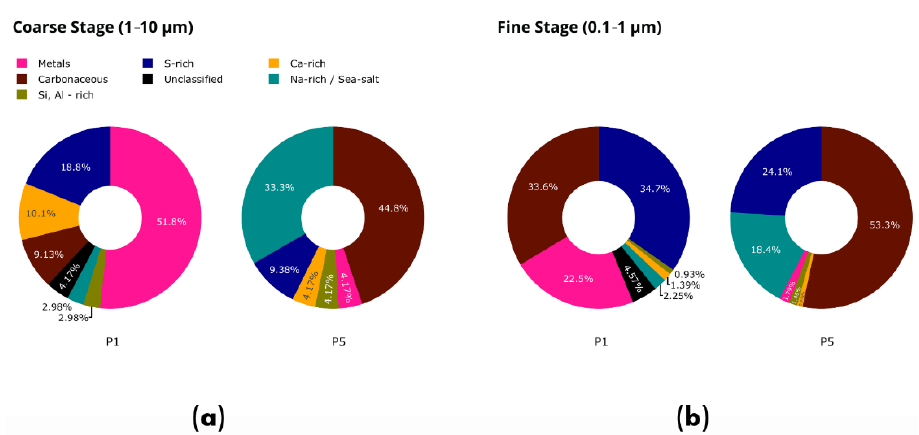
Figure 11. Relative contribution of different particle types during P1 and P5, respectively, for the TRAPS fine fraction (( a ) coarse stage) and ultrafine fraction (( b ) fine stage).